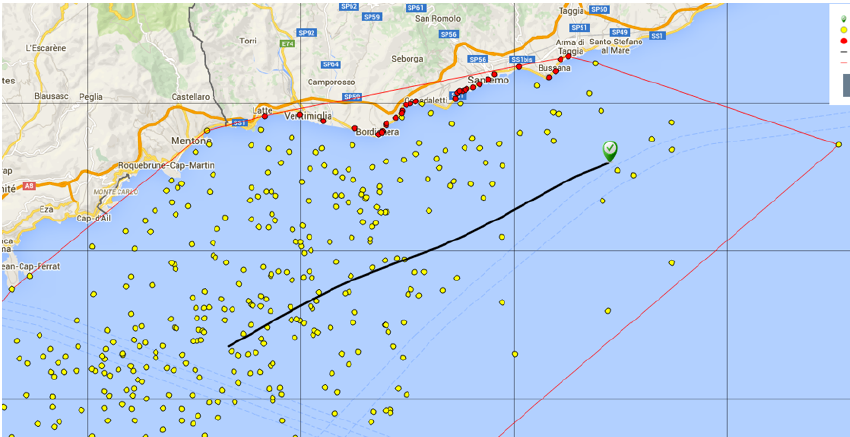
Figure 8. Detailed visualisation of the output of the